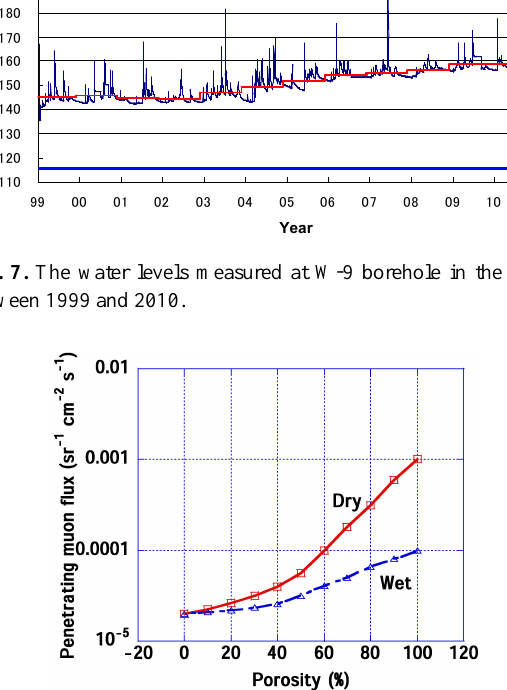
Fig. 8. Penetrating muon flux before and after saturating the porous rock with